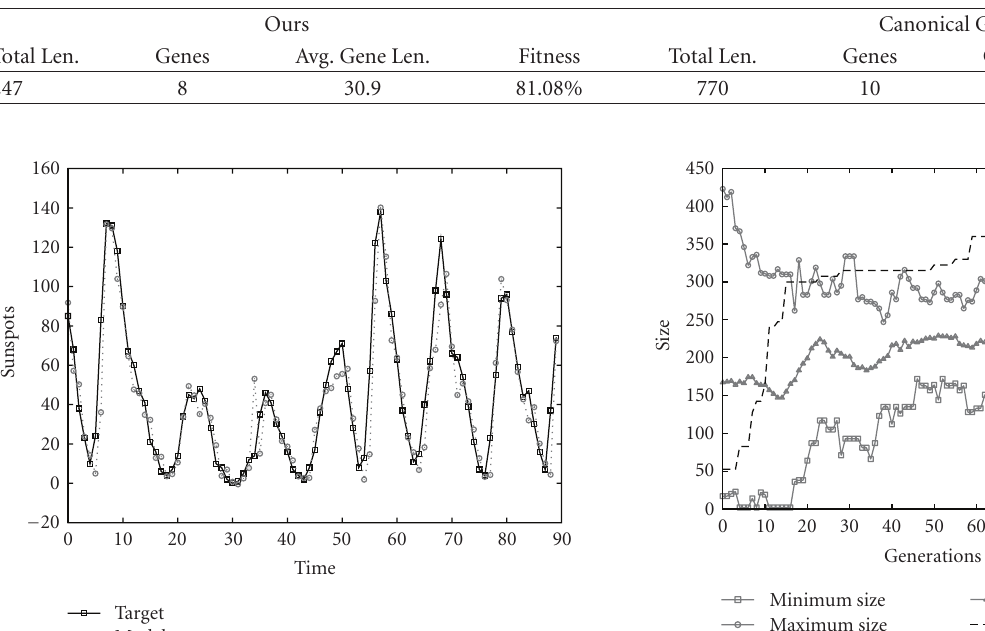
Table 3: Summary of classification experimental results.